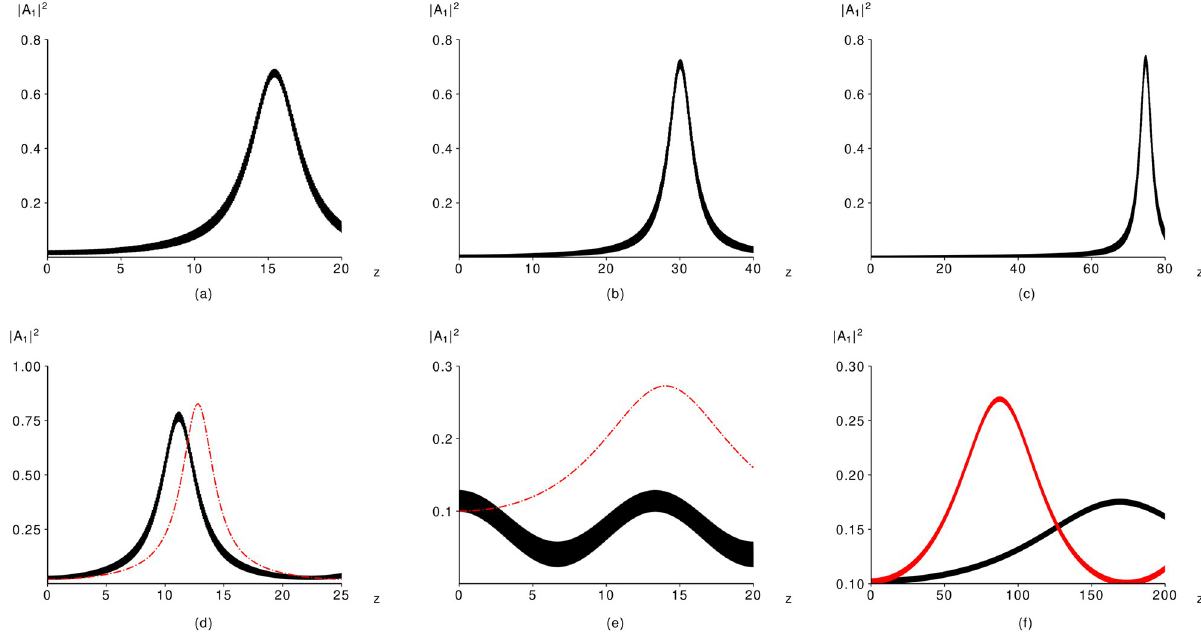
Fig 4. Computer simulation results of the original problem (black solid lines) and the modified problem (red dashed-dotted lines) at γ = 4, Δ 21 k = 80 (a- e), 500 (f), φ 0 = 0 and (| A 10 | 2 , | A 20 | 2 = (0.01, 0.4) (a), (0.001, 0.4) (b), (0, 0.4) (c), (0.02, 0.3) (d), (0.1, 0.5)